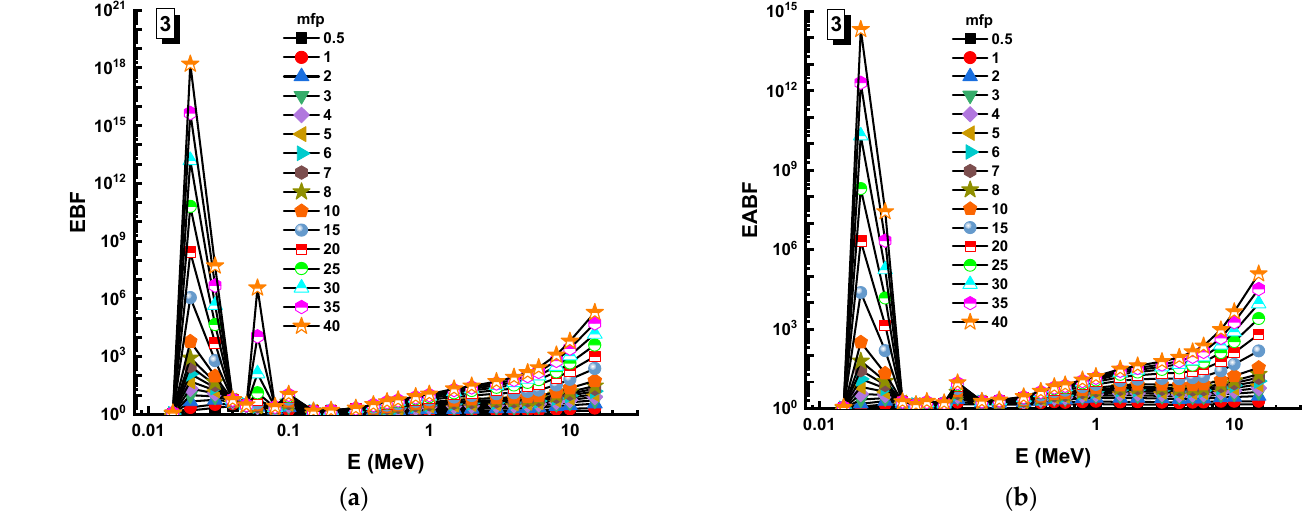
Figure 10. Variation of ( a ) EBF and ( b ) EABF against photon energy for Sample 3.